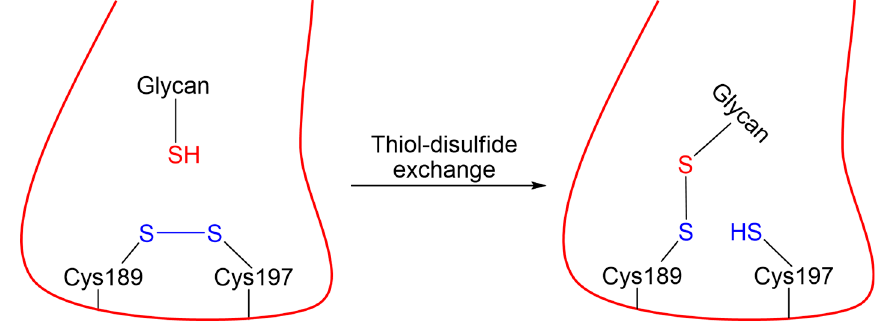
Scheme 1. Representation of possible thiol-disulfide exchange for inhibition of BabA.